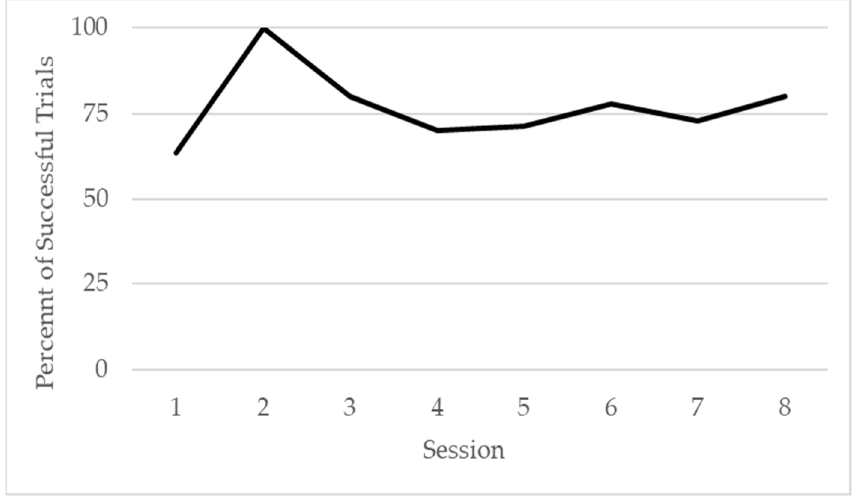
Figure 8. Percentage of Successful Trials across Phase 2.